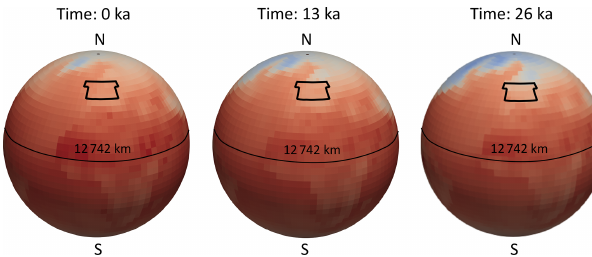
Figure 1. Paleotemperature data from MPI-ESM for the time steps at 0, 13 and 26ka. The black rectangle represents the outline of the surface temperatures used for the transient simulations of the CEBS model. Here, 0ka denotes the present-day conditions and 26ka the paleoclimate conditions from 26kyr before the present